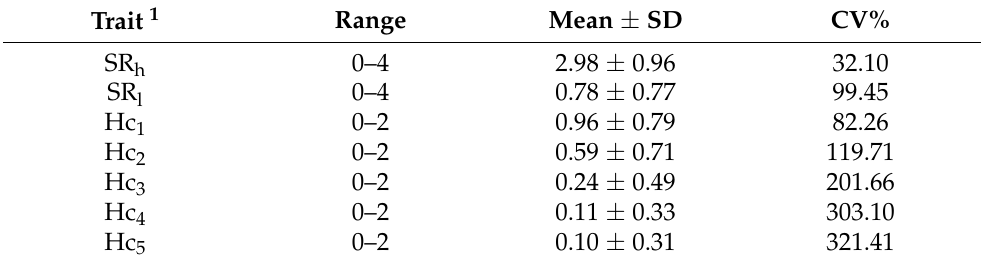
Table 4. Descriptive statistics for all the individuals in the population.